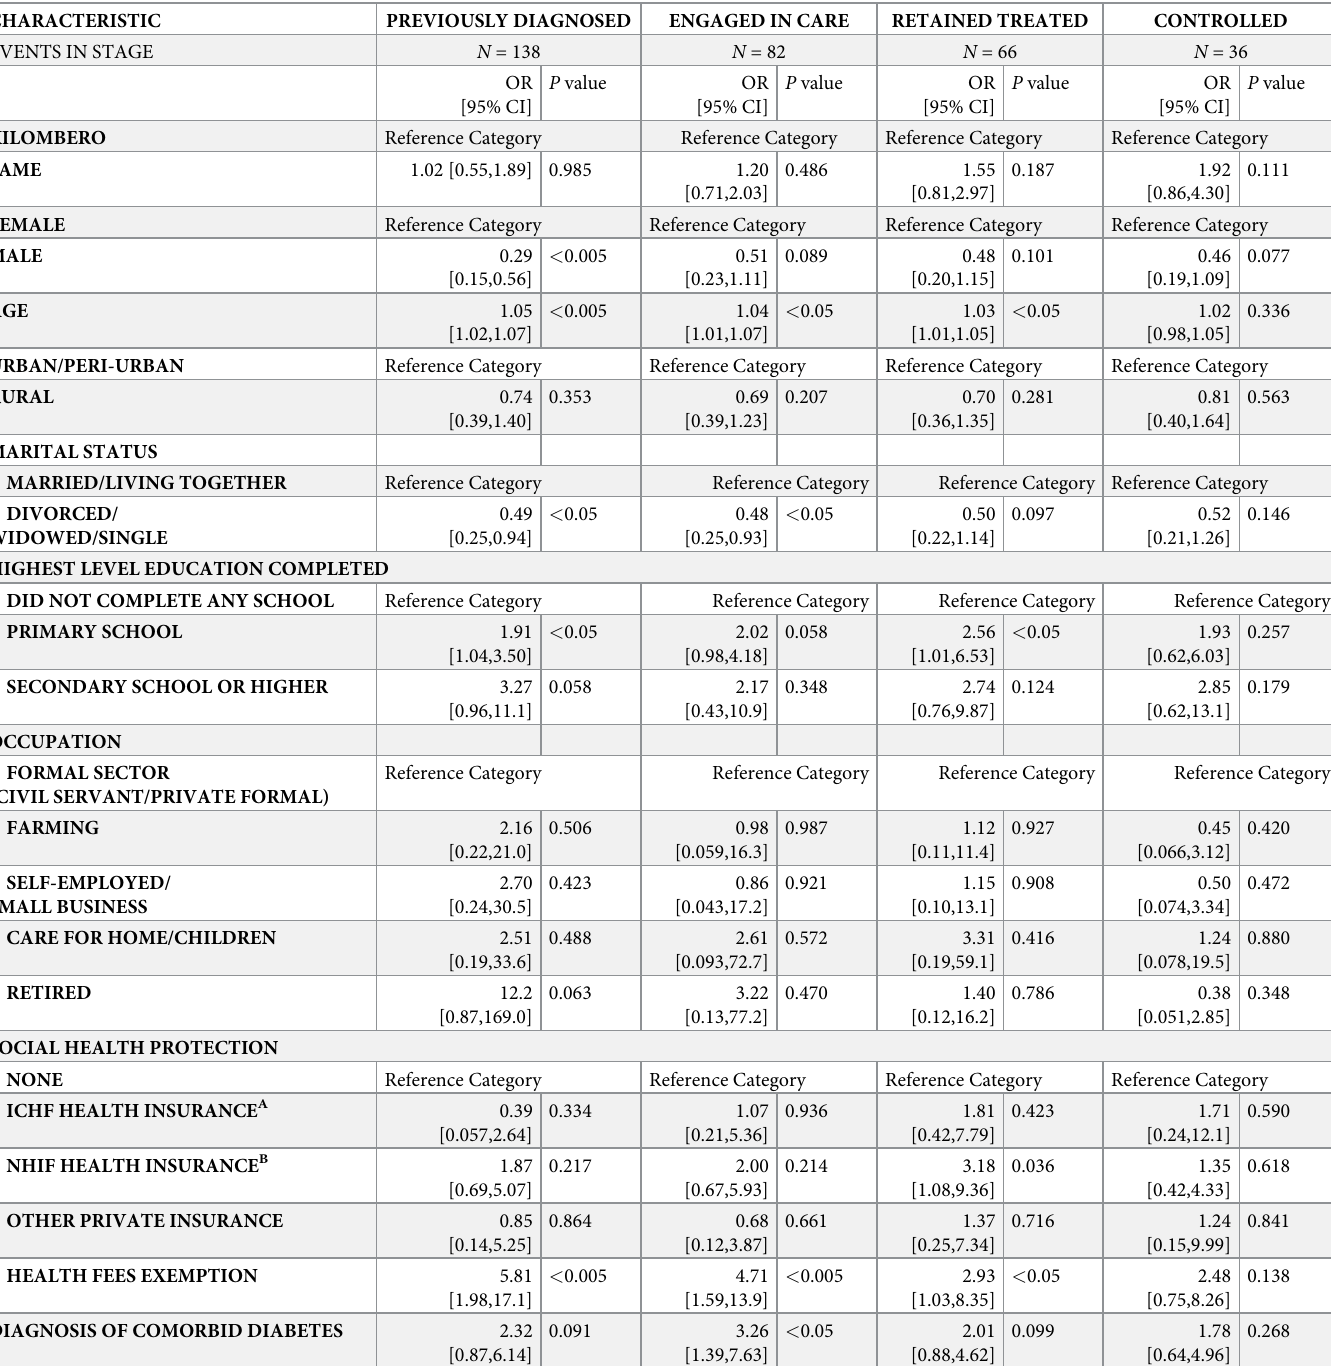
Table 2. Multivariable regression analysis † for each of the four steps of the Hypertension care